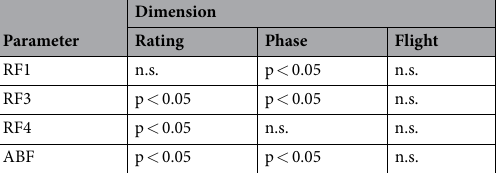
Table 1. ANOVA analysis on the level of significance 0.05; n.s.–not